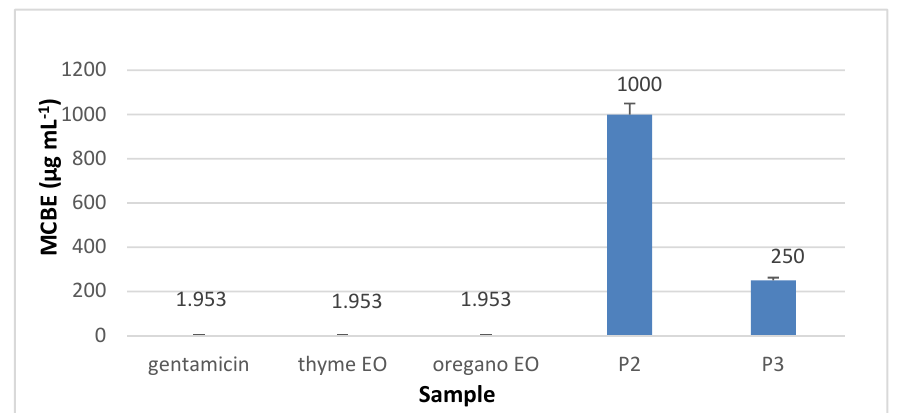
Figure 15. MCBE of collagen nanofibres loaded with essential oils against E. coli ATCC 25922, as compared to gentamicin and essential oils.